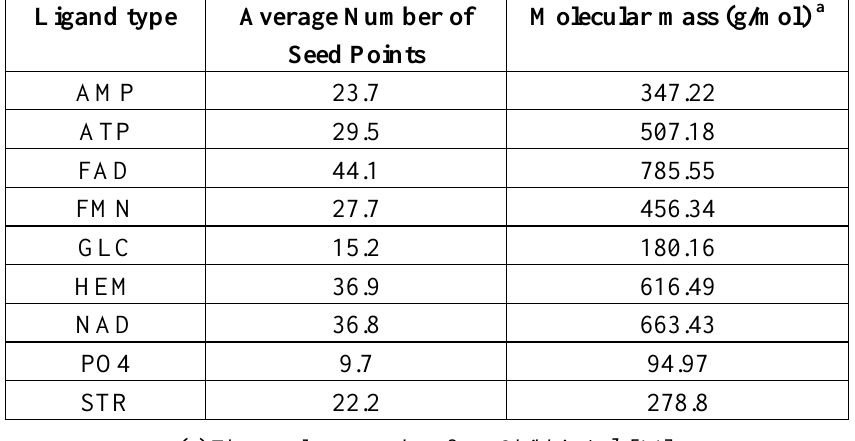
Table 1. The average number of seed points for each ligand type in the benchmark